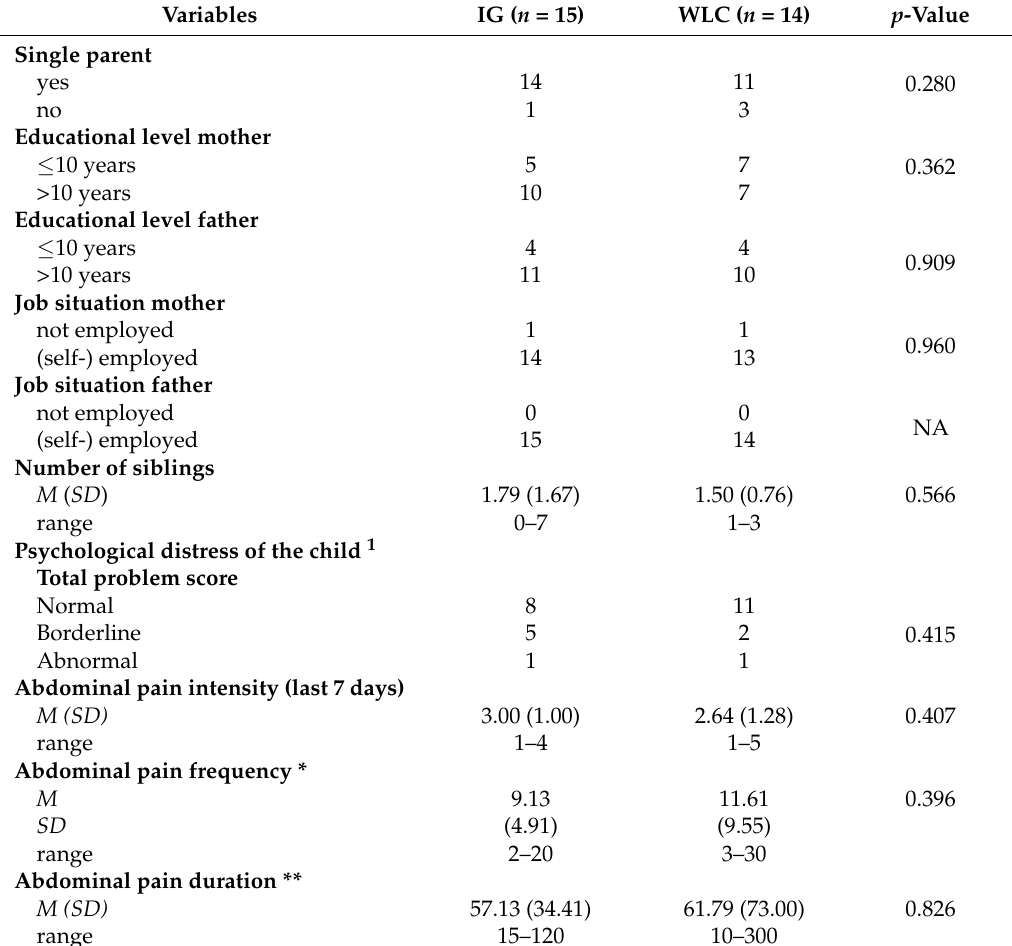
Table 1. Demographic data and baseline pain characteristics of the sample ( n =